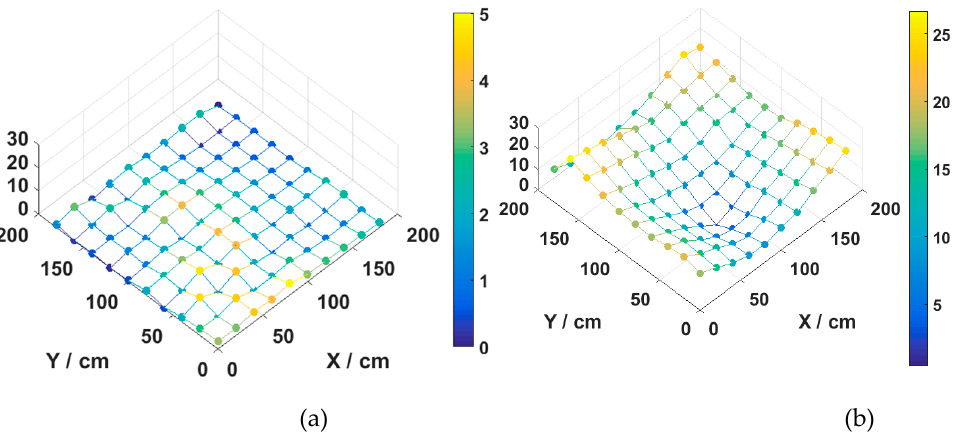
Figure 14. Distribution of positioning error for ( a ) MMBP algorithm with arbitrary training data set and ( b ) traditional RSS-based algorithm.